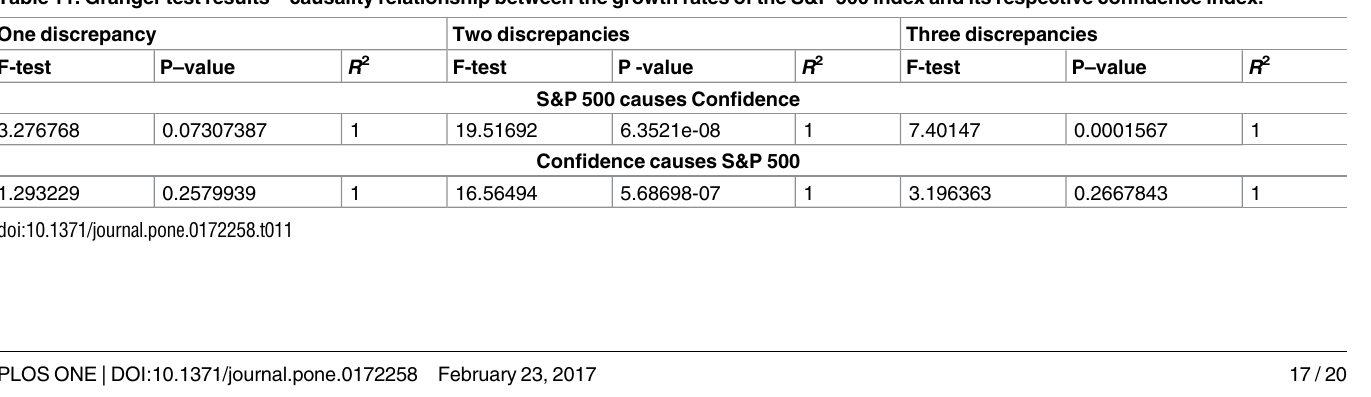
Table 11 shows the result of the Granger test for the growth rates of these indices. The